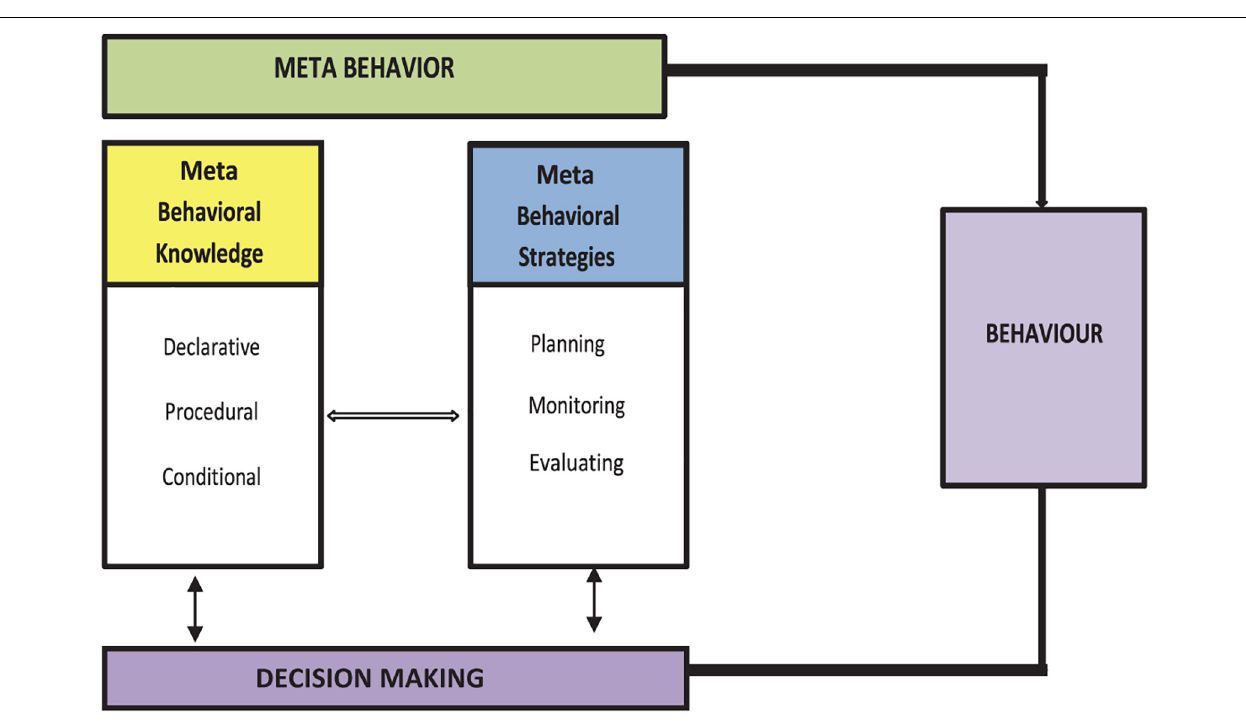
FIGURE 2 | Conceptual meta-behavior skills framework adapted from Abdullah and Rahman